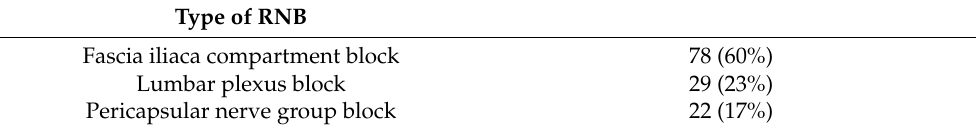
Table 2. Type of RNB for hip fracture. Type of